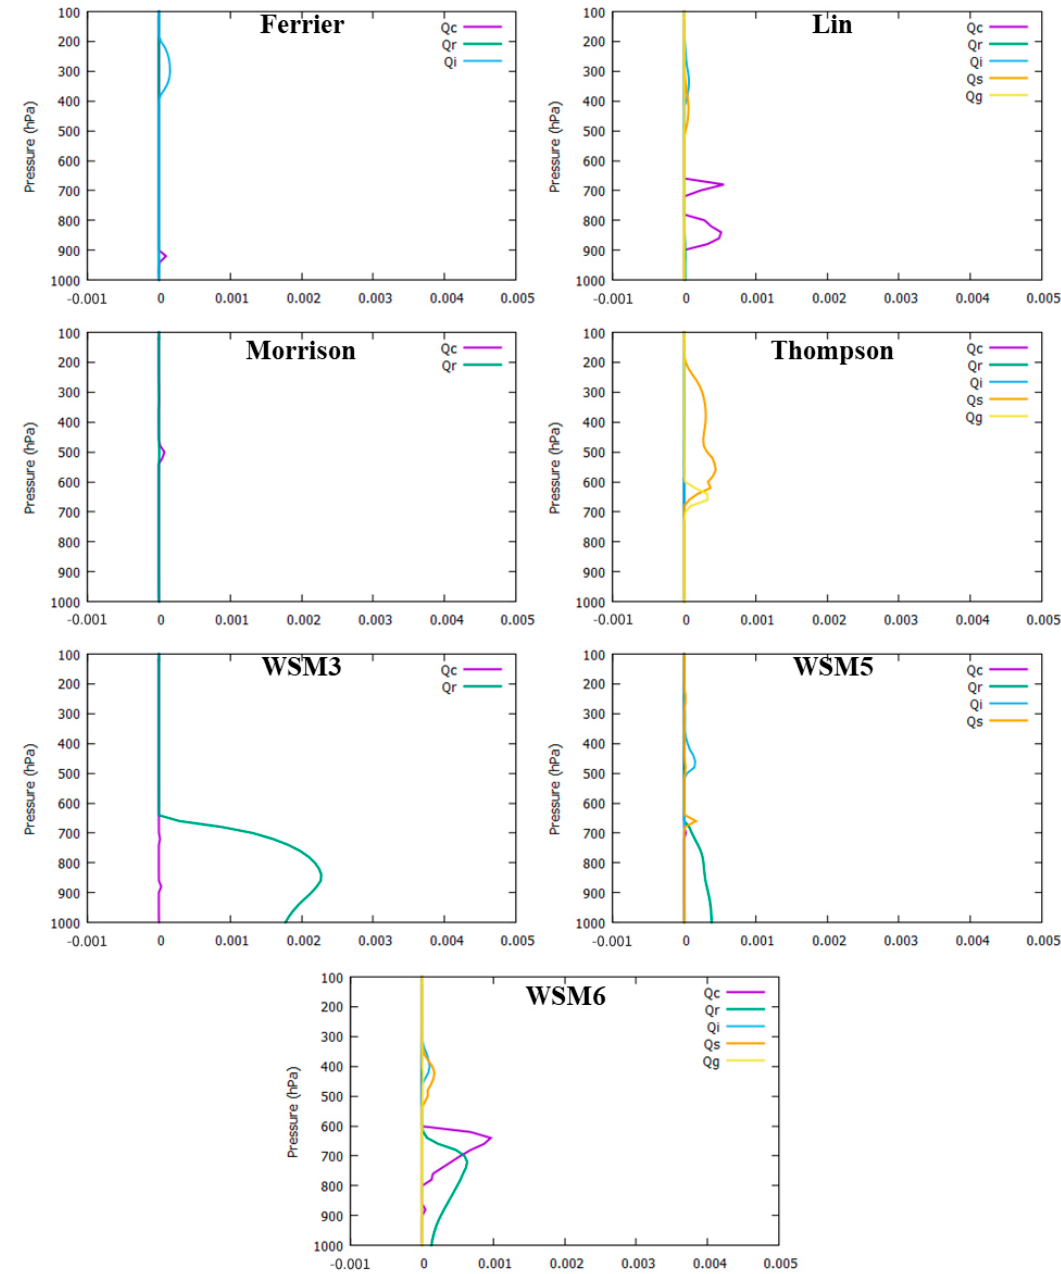
Figure 8. Time evolution of area averaged mixing ratios (g/kg) for the cyclone Hudhud (Qv-Water Vapor, Qc-Cloud Water, Qr-Rain Water, Qi-Ice, Qs-Snow, Qg-Graupel).